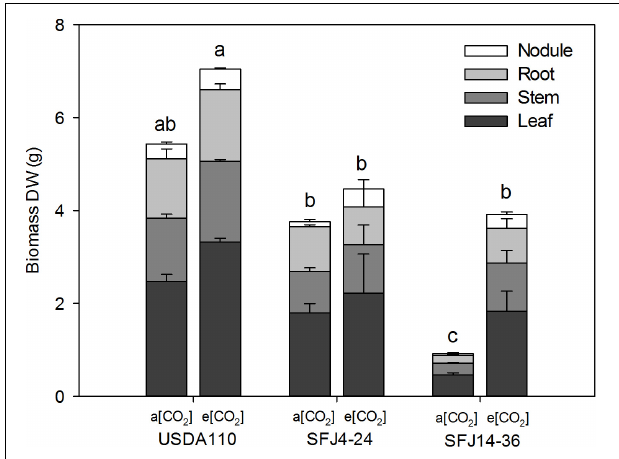
FIGURE 1 | Effect of [CO 2 ] on soybean biomass in plants inoculated with three different B. japonicum strains. Nodule, root, stem, and leaf biomass (g DW plant - 1 ) of soybean plant grown at a[CO 2 ] (400 ppm) and e[CO 2 ] (700 ppm) and inoculated with three Bradyrhizobium japonicum strains (USDA110, SFJ4-24, and SFJ14-36). Bars correspond to the mean ± SE of n = 6 of the biomass of each tissue. Results of statistics for total biomass (the sum of nodule, root, leaf, and stem) are shown (two-way ANOVA, P < 0.05). Different letters indicate significant differences (Tukey post hoc test P <